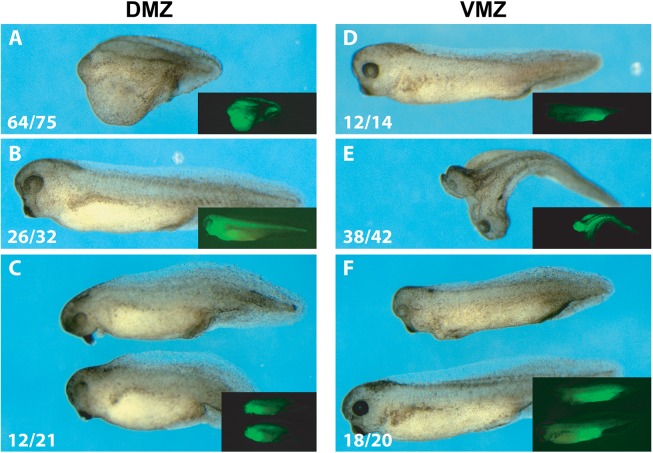
Brg1 cooperates with maternal Wnt signaling for axis formation in X. laevis.Panels (A-C) axial rescue of DMZ-injected BMO1 morphants (10ng) by coinjected ß-catenin mRNA (250pg). (A) DMZ-injected BMO1 morphant with severly impaired antero-posterior axis (n = 64/75 “headless”); (B) overexpression of ß-catenin in DMZ does not cause gross abnormalities (n = 26/32 wt-like); (C) coinjection of BMO1 and ß-catenin rescues the truncated 1° axis (n = 12/21 heads with eyes and cement gland). Panels (E-G) show that de novo induction of a second embryonic axis by ß-Catenin (250pg) depends on endogenous Brg1 activity. (E) VMZ-injected BMO1 morphants (10ng) display wt-like morphology (n = 12/14; see also Fig 2D); (F) VMZ-injection of 250pg β-catenin mRNA induce a second body axis (n = 38/42 complete secondary heads with eyes and cement gland); (G) Coinjection of BMO1 with β-catenin mRNA blocked almost completely the induction of secondary axes (n = 18/20 single axis status; 1 double axis remaining). Correct targeting of injections was verified by fluorescence from coinjected GFP mRNA (100pg; see inserted images).